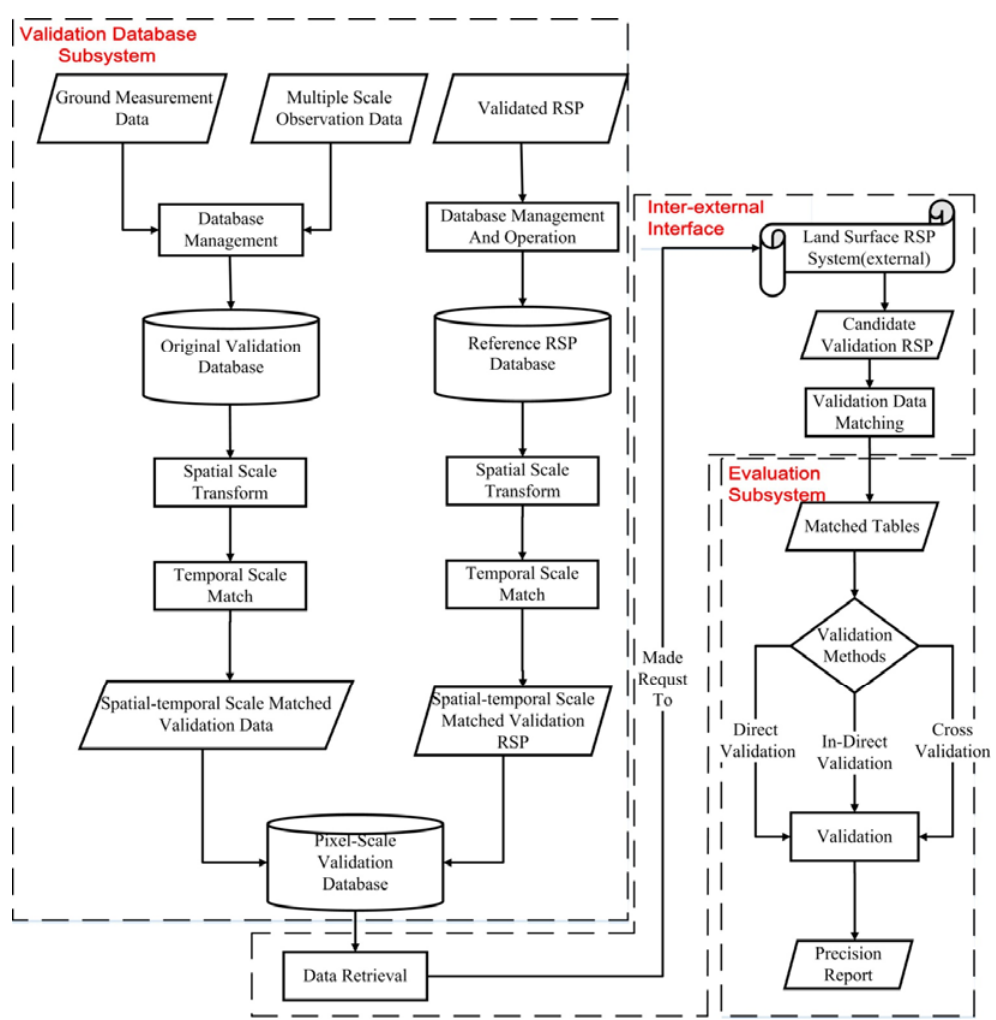
Figure 5. The structure and workflow of the validation system of the LAPVAS.